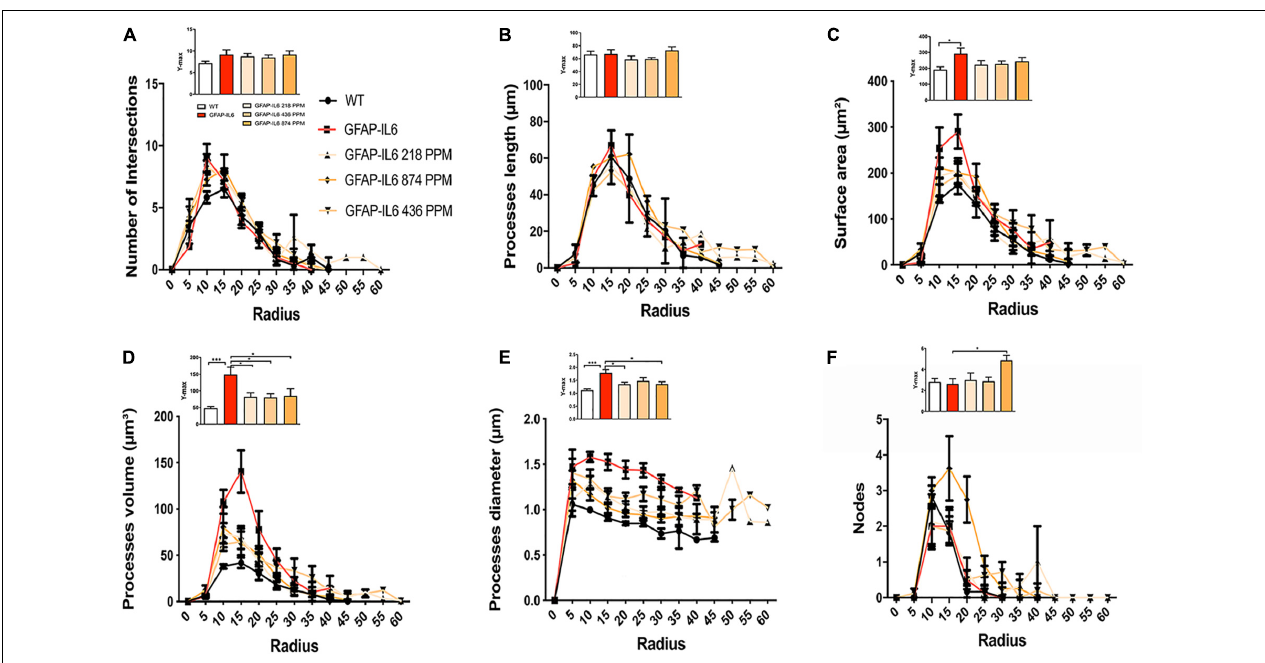
FIGURE 10 | MC retracted the size of microglial cells in the hippocampus. A Sholl analysis revealed a significant change in the surface area, processes volume and processes diameter of microglia between wild type and GFAP-IL6 inflamed microglia both in the hippocampus. (A–F) MC retracted processes volume and processes diameter compared with the GFAP-IL6 mice. This can be observed in the peaks of the distributions of different morphological features being closer to the center compared with the WT and GFAP-IL6 mice, we call it X at Ymax. One-way ANOVA test. Significance = * p < 0.05, *** p < 0.0001.